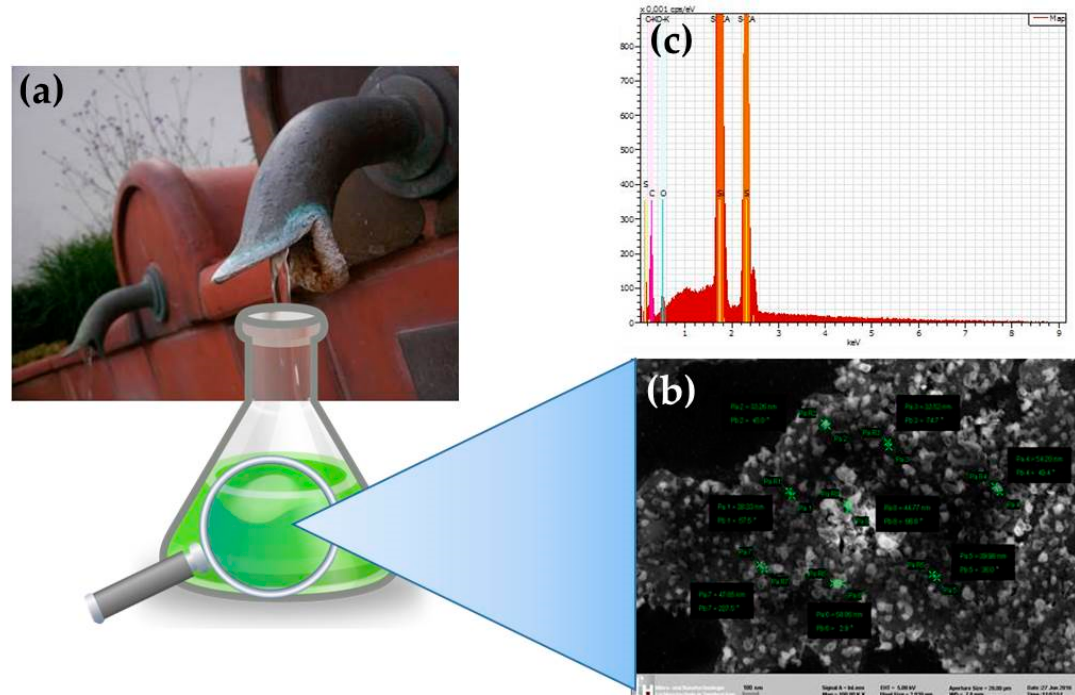
Figure 3. ( a ) The mineral wells in and near the town of Aachen in Germany are rich in sulfur, primarily in form of hydrogen sulfide (H 2 S). Solid deposits of inorganic matter can therefore be found, for instance, at the Marktbrunnen in Burtscheid (image kindly provided by Roman Leontiev). ( b ) A microscopic investigation at 10,000-fold magnification reveals numerous microscopic and sub-microscopic particles and irregular agglomerates in this kind of water which ( c ) according to Energy Dispersion X-ray spectroscopy (EDX) consist of primarily of calcium salts and elemental sulfur [42].